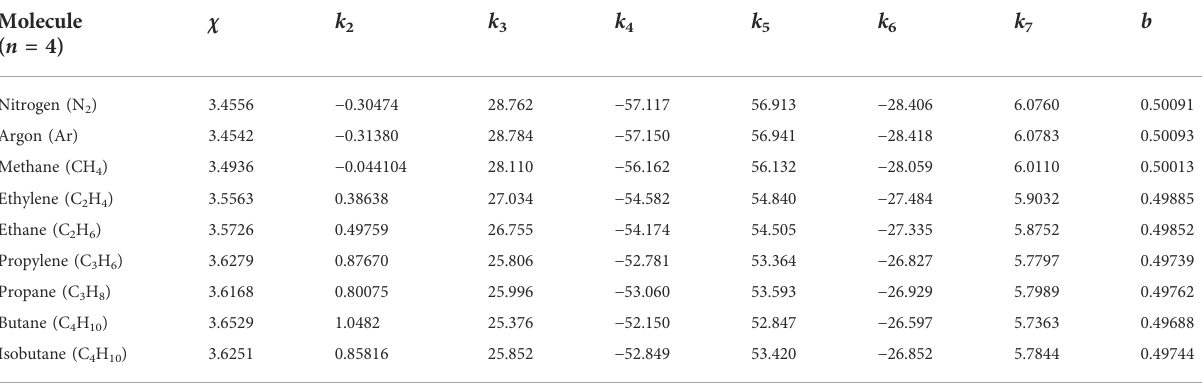
TABLE 1 Coef fi cients of the n = 4 Janus van der Waals equations for nine molecules.